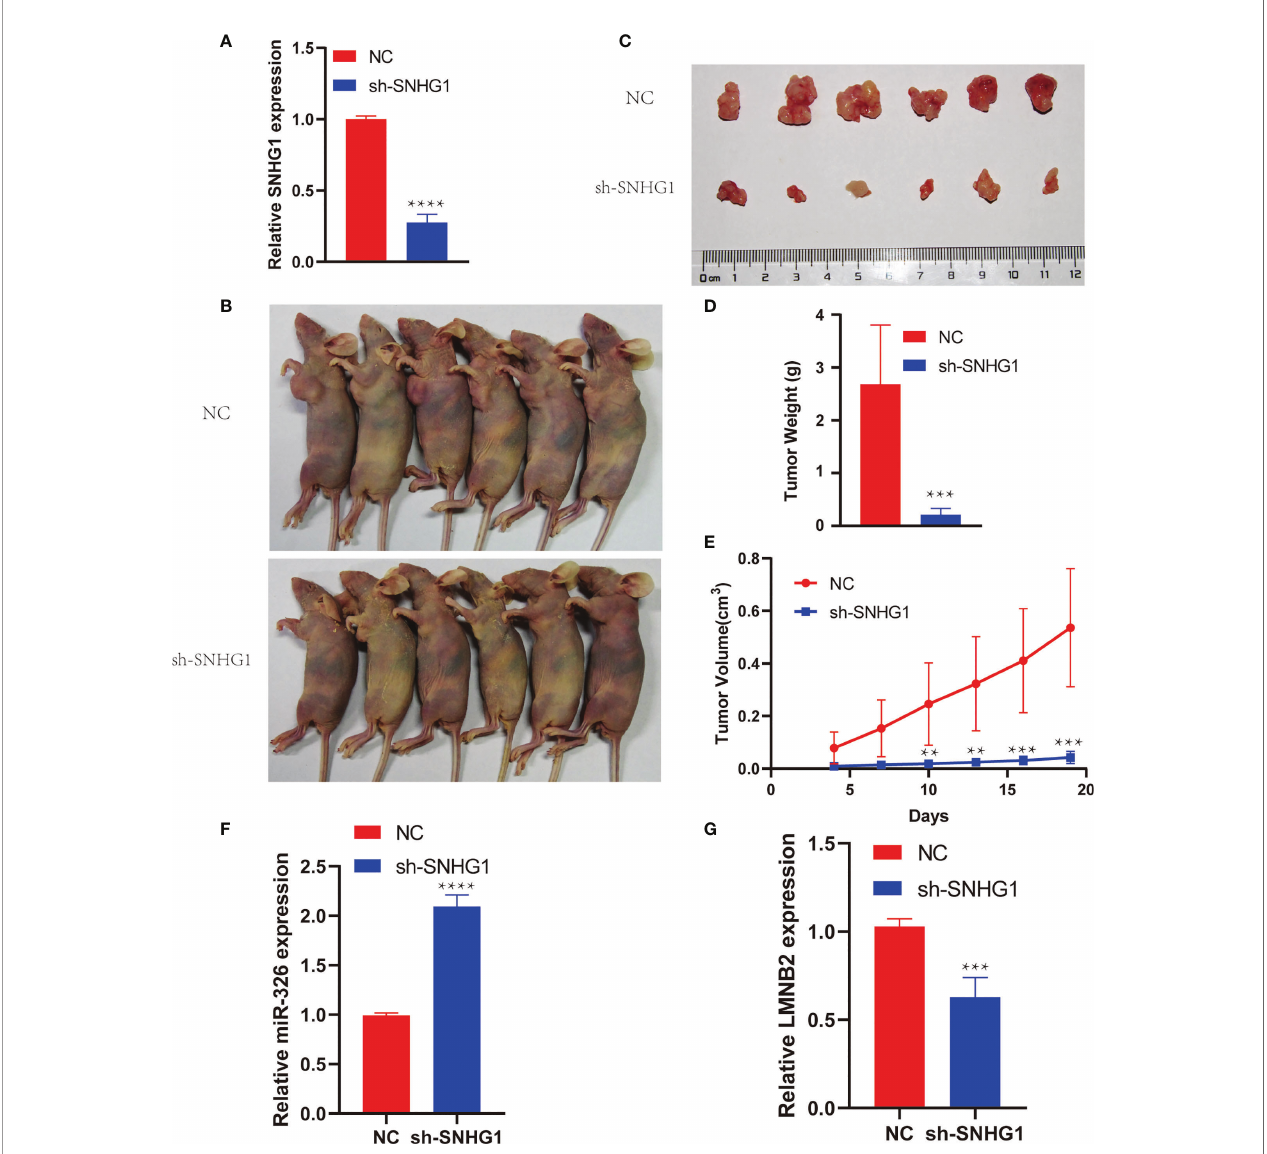
FIGURE 6 | SNHG1 promotes hepatocellular carcinoma (HCC) tumor growth in vivo . (A) RNA levels of SNHG1 in Huh7 cells with SNHG1 knockdown detected by RT-qPCR (****p < 0.0001). (B) Representative images of mice bearing tumors from SNHG1 knockdown group and control group. (C) Representative tumor images were shown. (D, E) Quanti fi cation of tumor weight and tumor volume of individual mice following the injection of HuH7 cells with SNHG1 knockdown or control cells (**p < 0.01, ***p < 0.001). (F, G) Expression of miR-326 and LMNB2 in tumor of sh SNHG1 group compared with control (***p < 0.001, ****p <